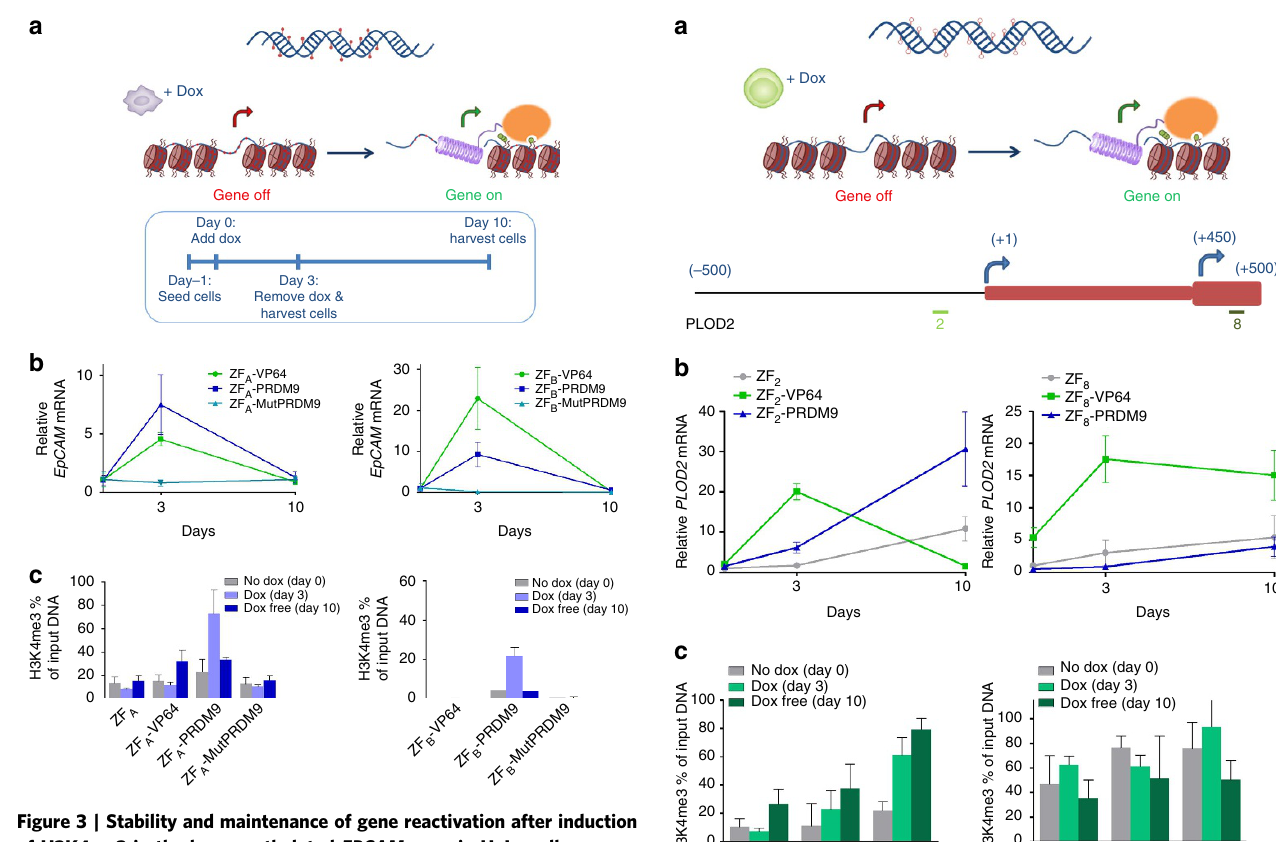
levels were as high as 35–40%. After subculturing, the H3K4me3 was sustained and reinforced for the ZF targeting region 2 (reflecting gene expression levels), while no clear difference was observed for region 8. The H3K4me3 enrichment was evaluated at a region 750 bp upstream of TSS to test for the spreading of the mark (Supplementary Fig. 3a). H3K4me3 seems to spread after subculturing the cells without dox.